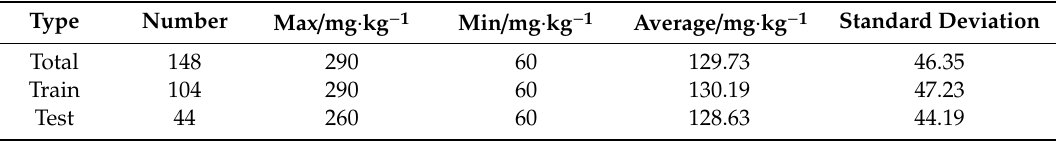
Table 7. Low concentration of soil-available potassium sample